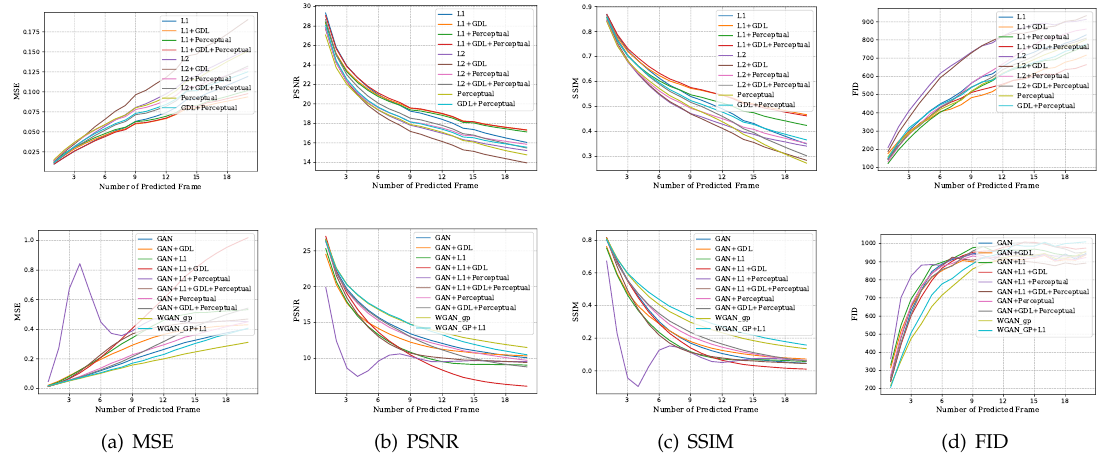
Figure A2. Mean values per predicted frame for the BDD100K evaluation dataset. (MSE and FID: smaller values are better, PSNR and SSIM: larger values are better).